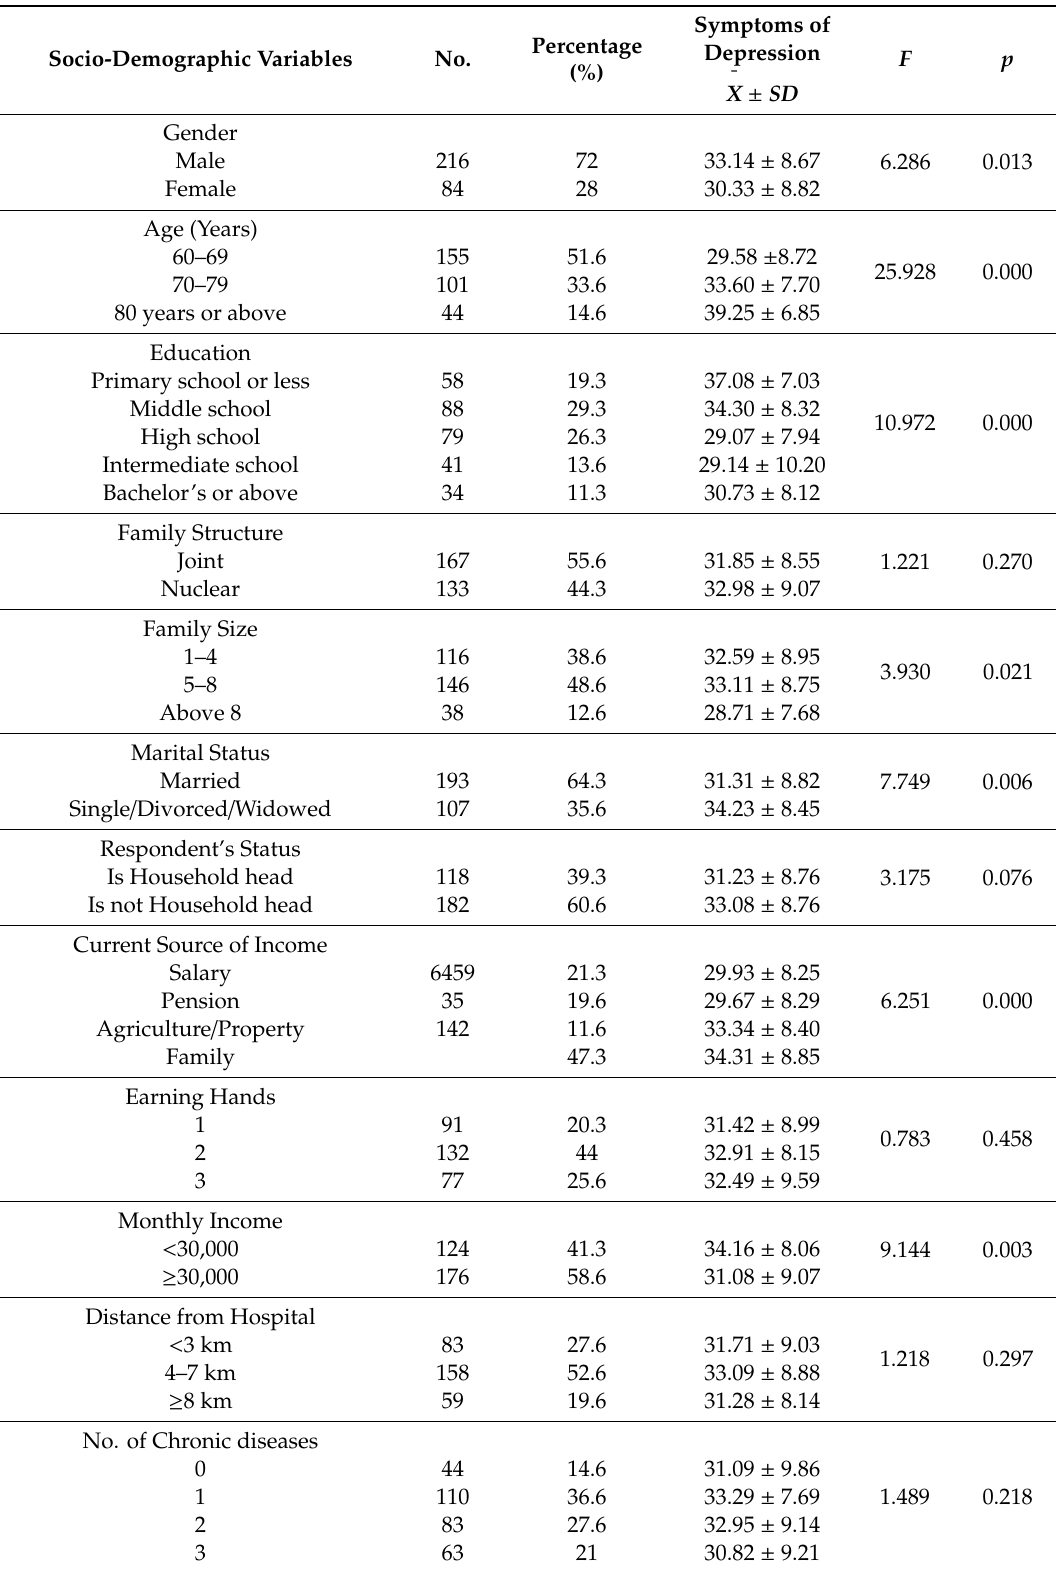
Table 1. Comparison of di ff erent socio-demographic characteristics with depressive symptoms.